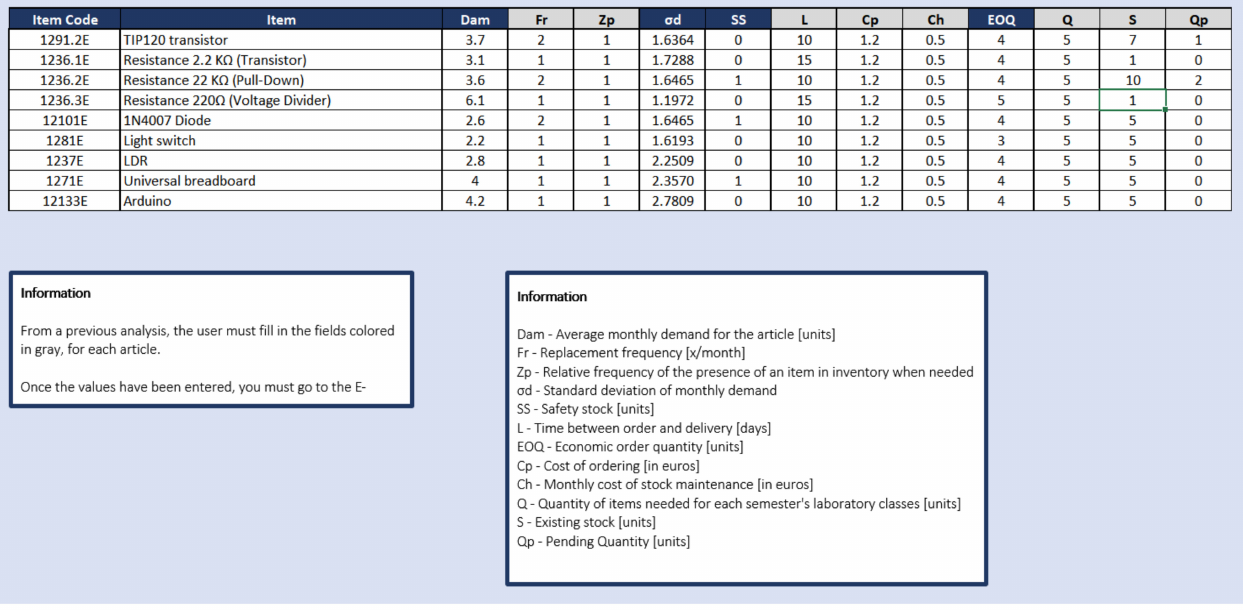
Figure 9. “Data” sheet.